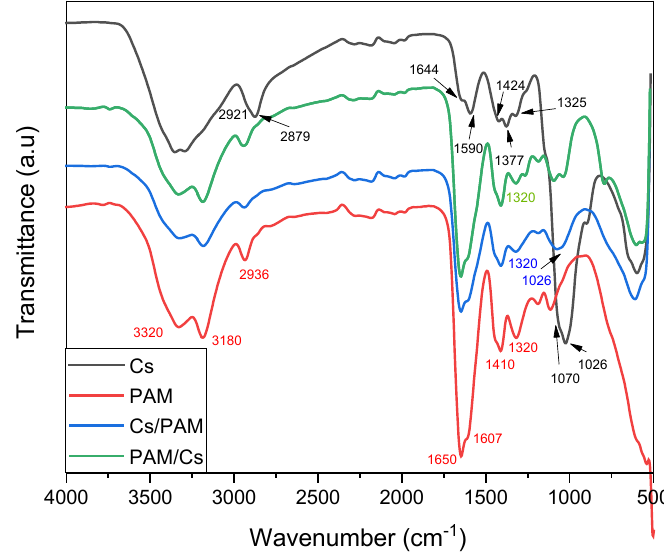
Figure 1. The FTIR spectra of Cs, PAM, Cs/PAM and PAM/Cs.